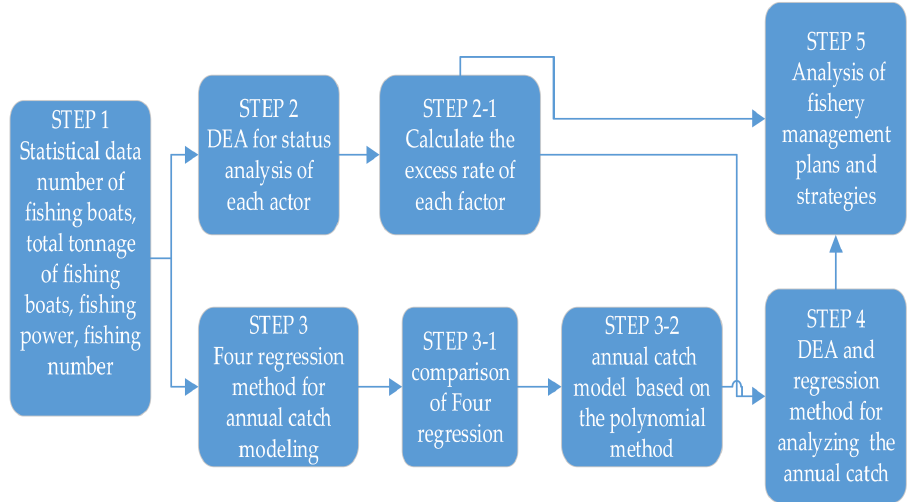
Figure 1. The method flow chart of this paper. Section 2.2 Material and